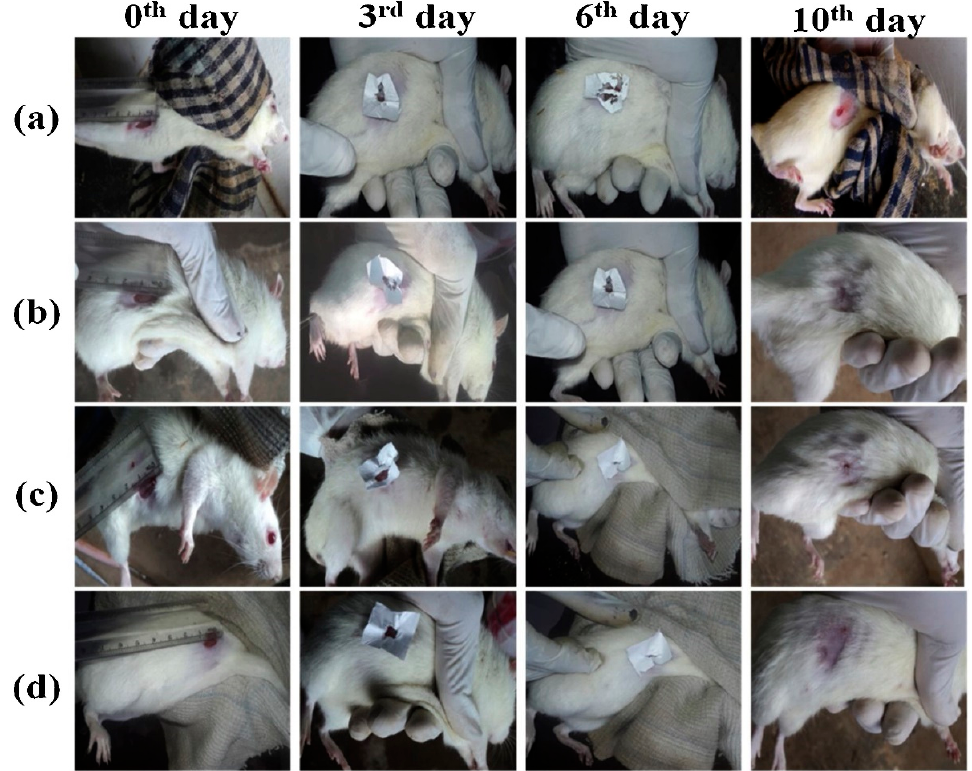
Figure 4. Representative photographs of wound closure on day 0, 3, 6 and 10. ( a ) PEO/GO ( b ) CeO 2 –PEO/GO ( c ) PM oil–PEO/GO, and ( d ) CeO 2 –PM oil–PEO/GO nanofibrous mats. Reprinted with permission from [88], copyright 2019 Elsevier.